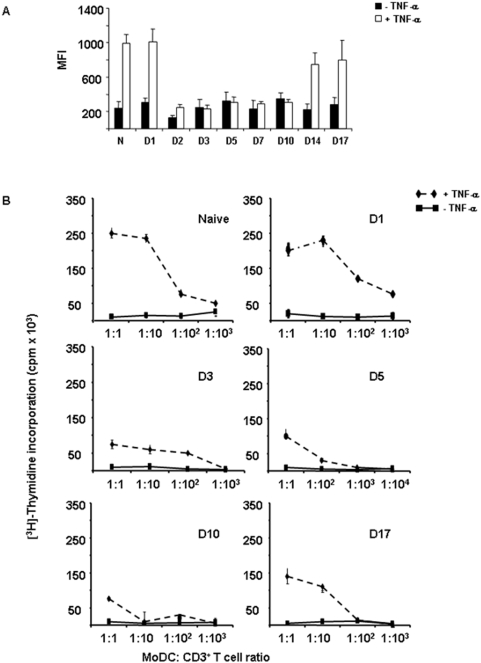
MoDCs from FMDV-infected swine do not up-regulate CD80/86 and do not stimulate T cells.A. Flow cytometric analyses were performed to measure the expression of CD80/86 on MoDCs differentiated from PBMCs isolated from FMDV C-S8c1-infected swine. It is indicated the mean fluorescence intensity (MFI) of CD80/86 on MoDCs from naïve animals (N) and MoDCs from FMDV C-S8c1-infected pigs at different times post-inoculation (indicated as D1, D3, D5, D10 and D17) before treatment with TNF-α (black bars) and after treatment with TNF-α (white bars). B. The allostimulatory capacity of MoDCs isolated from FMDV-infected swine either treated with TNF-α (diamonds and dashed line) or untreated (squares) at different times post-infection (indicated in each graph). MoDCs were irradiated and used as stimulator cells for allogeneic CD3+ T cells at the T cell/DC ratio indicated. Proliferation was measured in cpm (average cpm±SD) after [3H]Thymidine incorporation. Data is representative of three independent experiments.